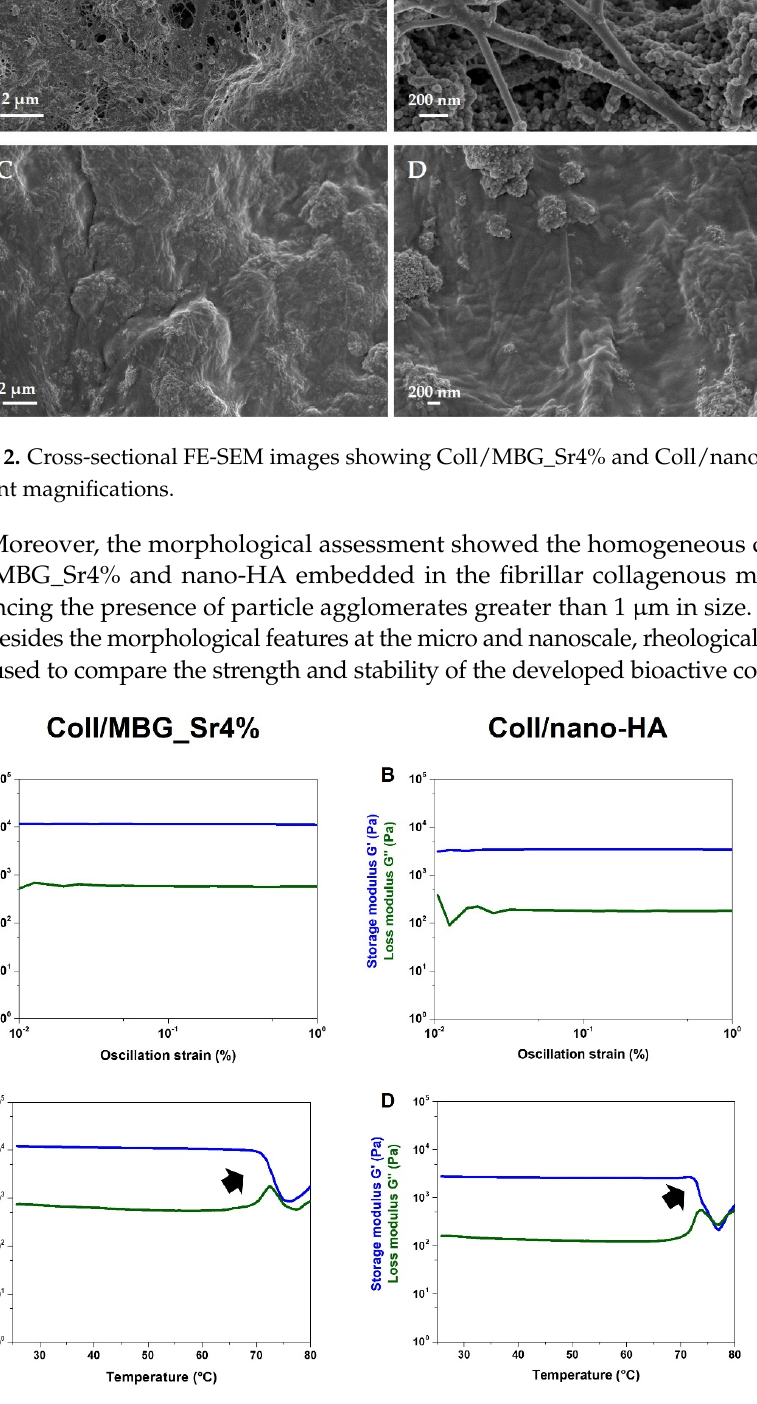
Figure 4. Hydrolytic ( A ) and enzymatic ( B ) degradation of Coll/MBG_Sr4% and Coll/nano-HA systems.